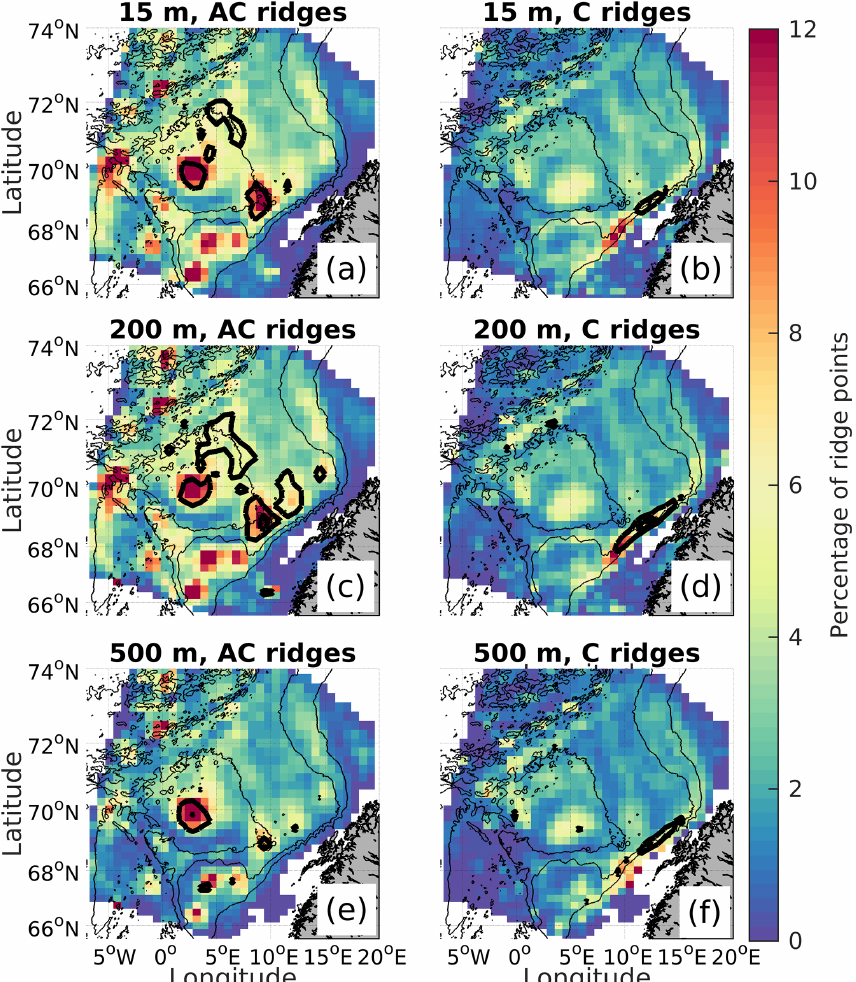
Figure 6. Density distribution of (a, c, e) anticyclonic ( ω n < 0) and (b, d, f) cyclonic ( ω n > 0) ridges for 3D drifters deployed at 15m (a, b) , 200m (c, d) and 500m (e, f) . The color bar shows the percentage of ridge points in each bin normalized to the total number of drifter data points in the same bins. Thin black contours show the 1000, 2000 and 3000m isobaths, while thick black contours indicate key locations where the drifters are trapped into eddies, i.e., the first ridge point on each ridge. These contours are shown for more than 200, 300 and 400 first ridge points. A bin never contained more than 490 first ridge points. Bin sizes are 0 . 73 ◦ × 0 . 25 ◦